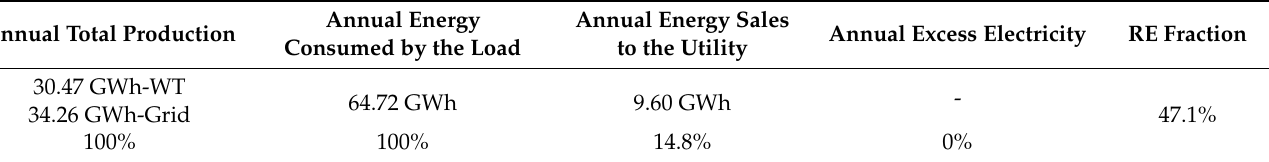
Table 2. Statistics on the planned system ’ s use of electricity.